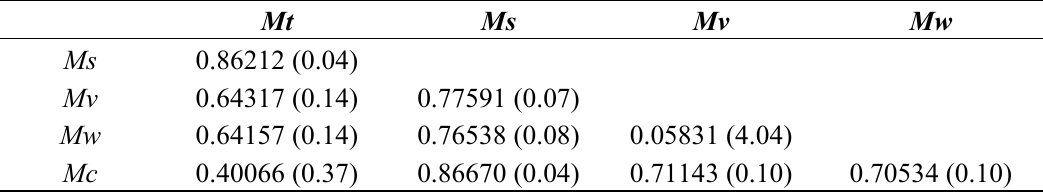
Table 6. The population differentiation parameter (F parentheses) between different populations of Mongolodiaptomus birulai . The values were calculated based on the COI gene according to the method of Hudson et al.